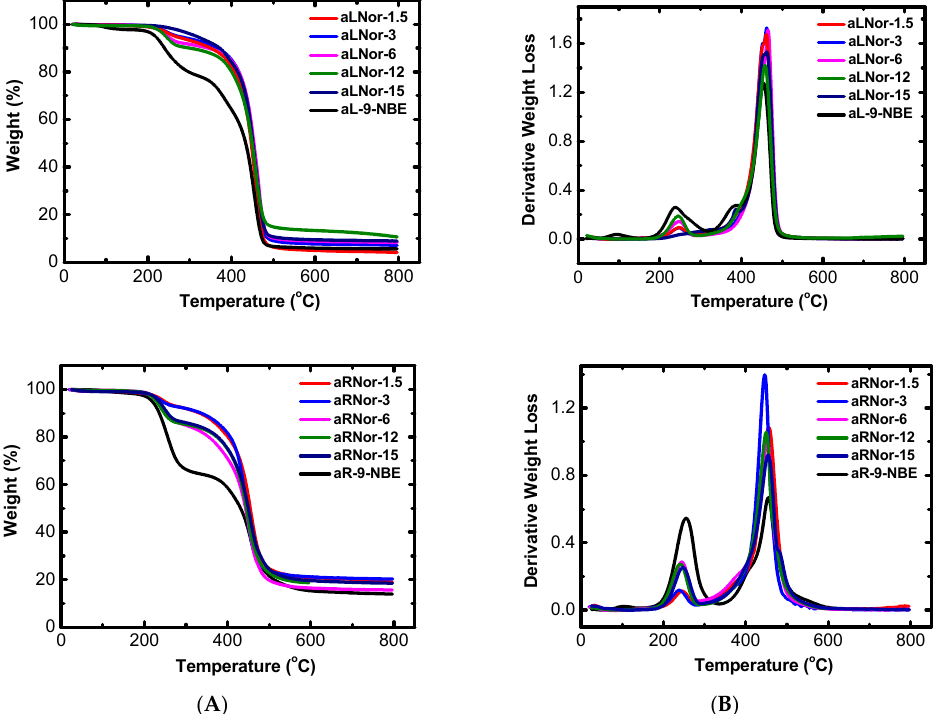
Figure 10. Weight loss with temperature ( A ) and derivative weight loss with temperature ( B ) for aLNor-xx and aRNor-xx aerogels, as indicated.